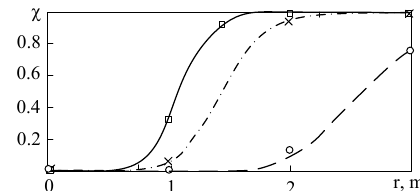
Fig. 1. Dependences of the vegetation removal degree on the distance from the center of the shell with a radius of 0.5 m (solid line), a radius of 0.65 m (dotted line), and a radius of 0.9 m (dashed line) ( Table 1 )